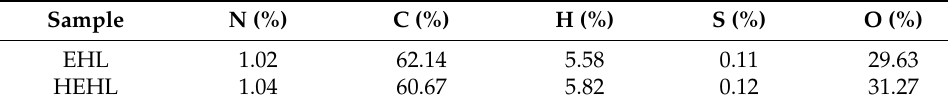
Table 5. Organic element content of EHL and